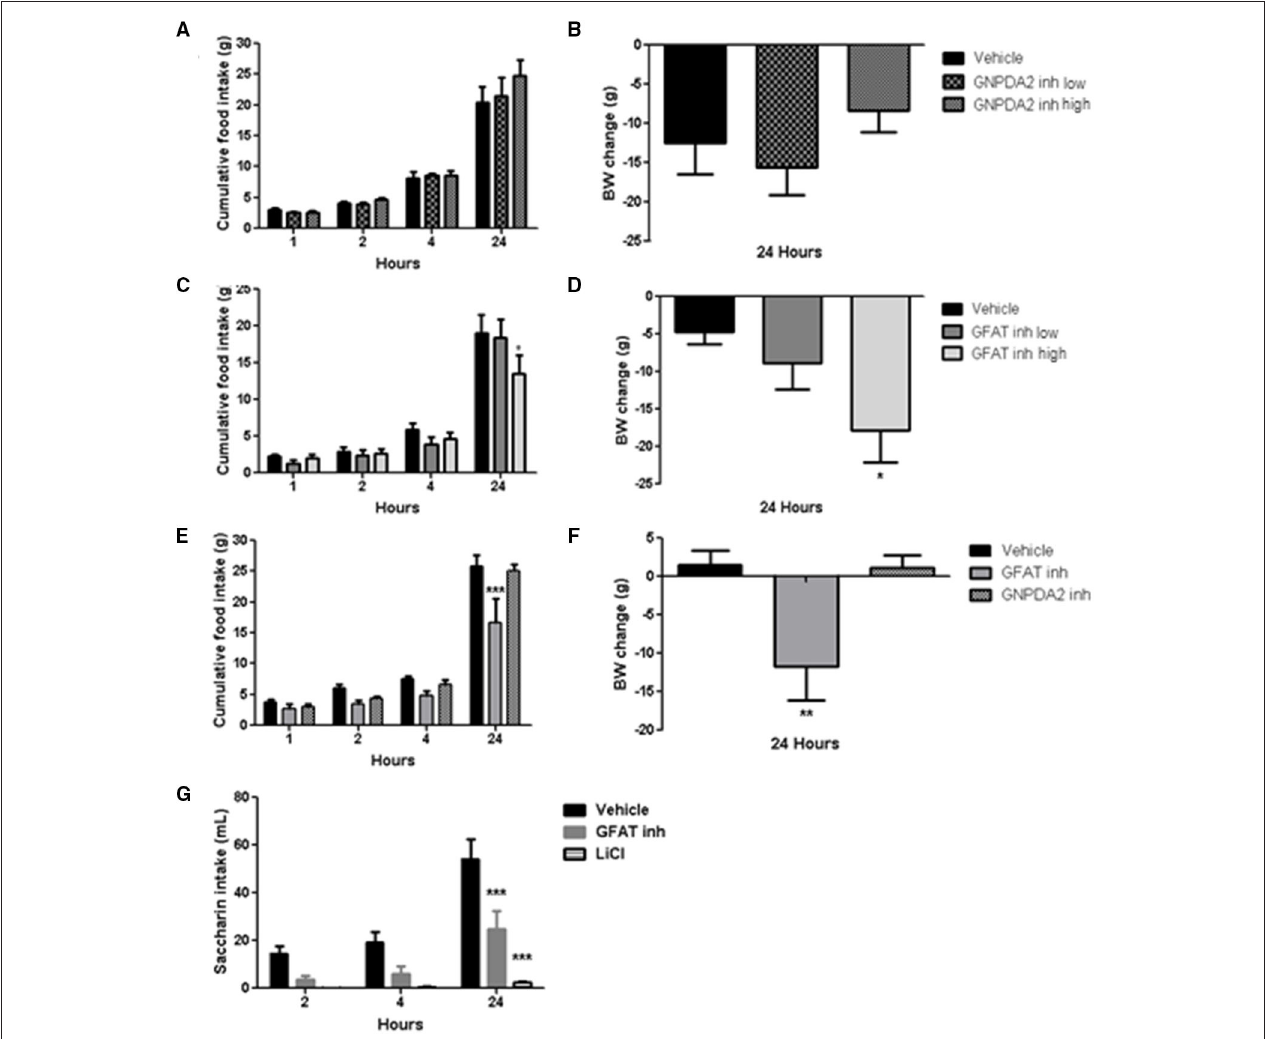
FIGURE 3 | Impact of central infusion of GNPDA2 and GFAT inhibitors on food intake (FI) and body weight (BW). (A, B) Infusion of different concentrations of GNPDA2 inhibitor and its effect on FI and BW. (C, D) Infusion of different concentrations of GFAT inhibitor and its effect on FI and BW. (E, F) Infusion the same concentration of GNPDA2 and GFAT inhibitors (150 µ g) and their effect on FI and BW. Repeated measures two- way ANOVA analysis for FI and one-way ANOVA for BW, * P < 0.05, ** P < 0.01, *** P < 0.001. (G) Conditioned taste aversion test with GFAT inhibitor and LiCl. Repeated measures two- way ANOVA analysis, Bonferroni posttest, *** P < 0.001. n = 8 rats per